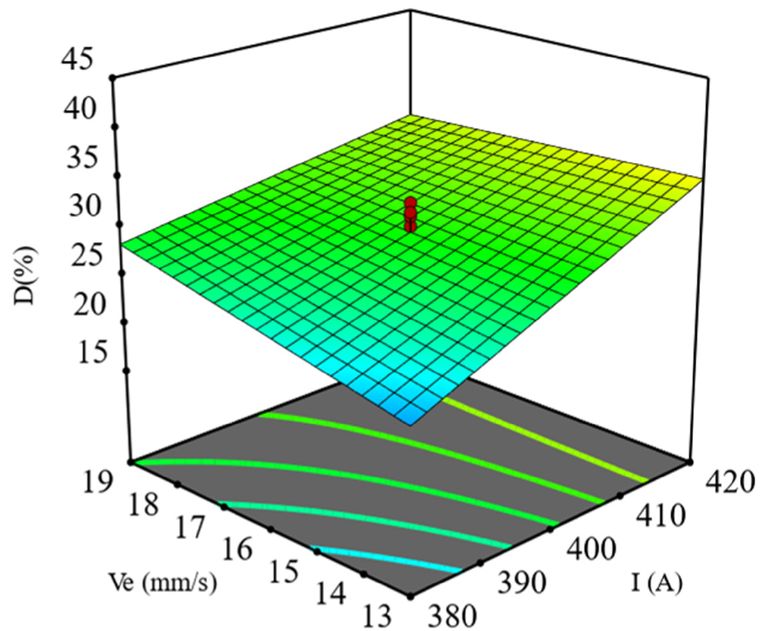
Figure 4. Combined effects of Ve and I(A) on D .